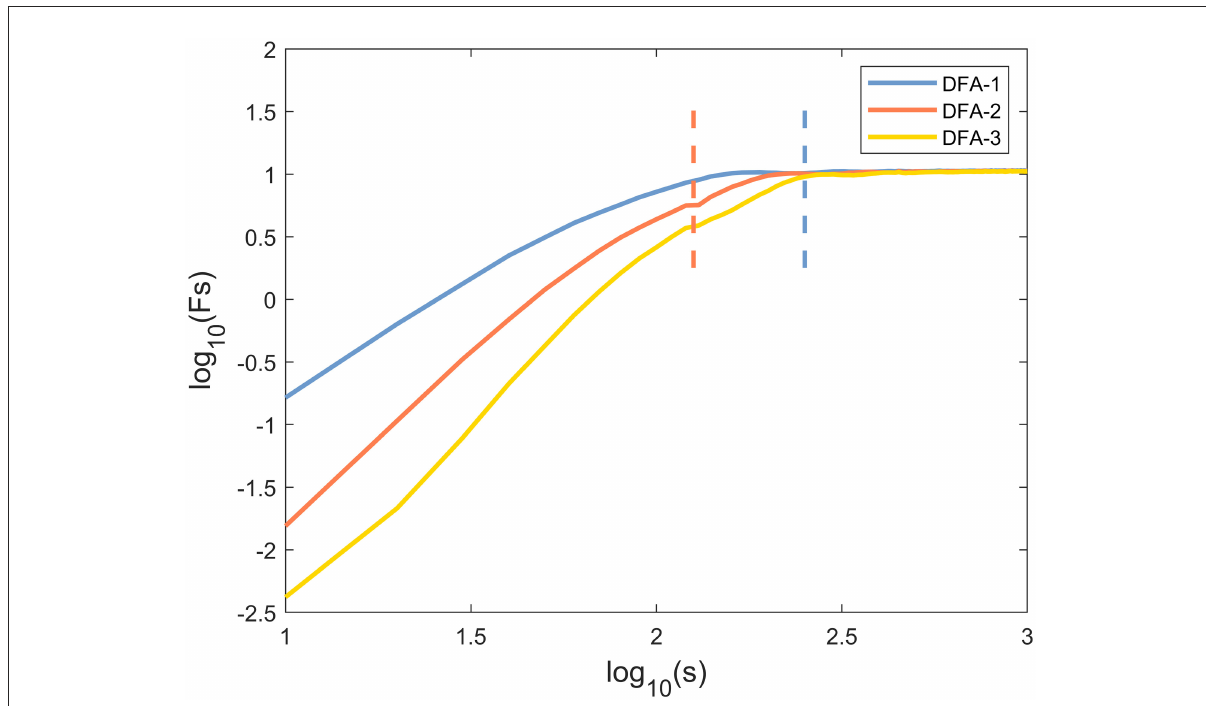
FIGURE1 A typical scaling pattern as observed for the knee angle time series of one healthy